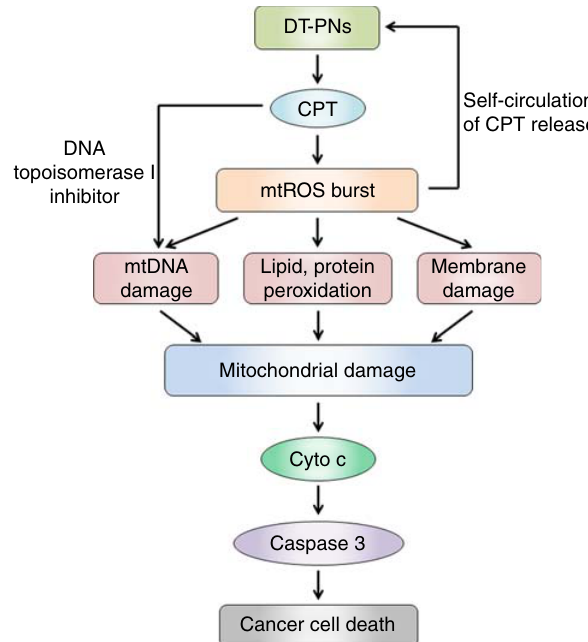
Fig. 10 Proposed mechanism for the mitochondria-speci fi c self-circulation of CPT release and mtROS burst to damage mitochondria and initiate cell apoptosis/death by dual-targeted polyprodrug nanoreactors